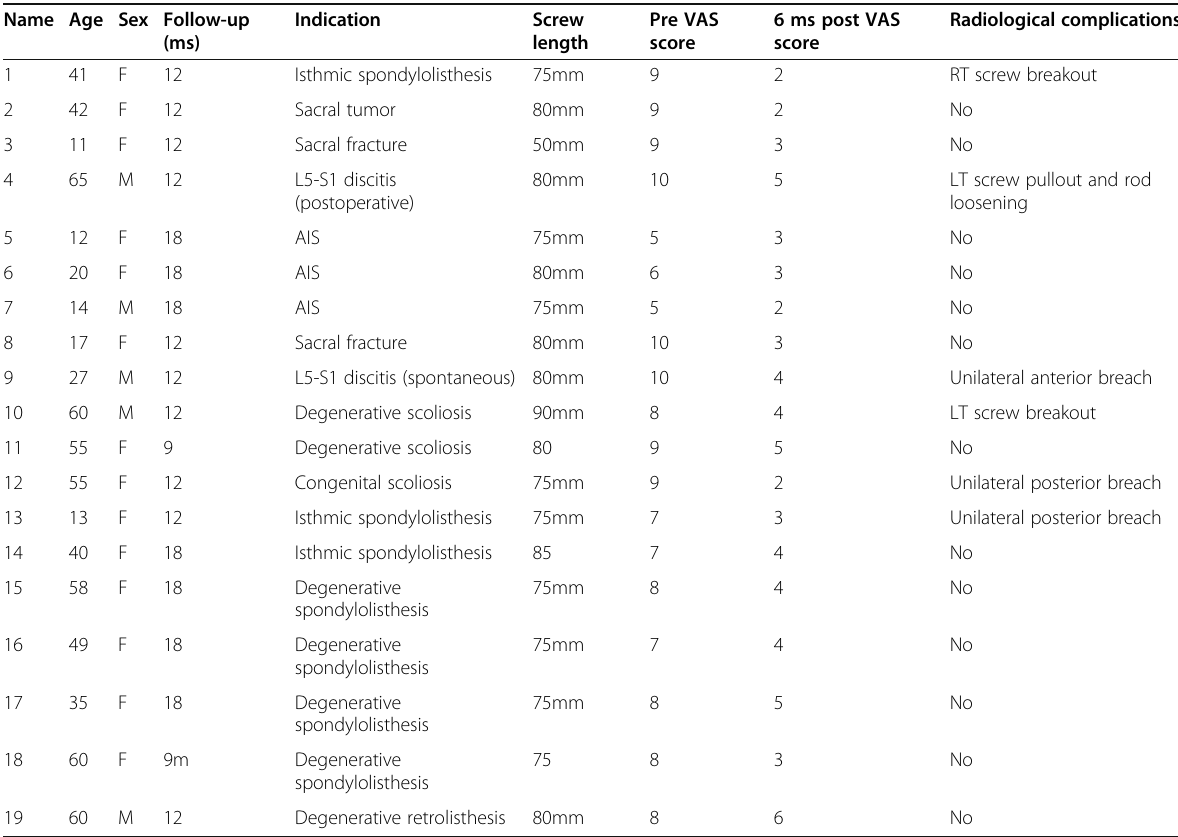
Table 1 The demographic, clinical, and radiological data of the 19 patients Name Age Sex Follow-up